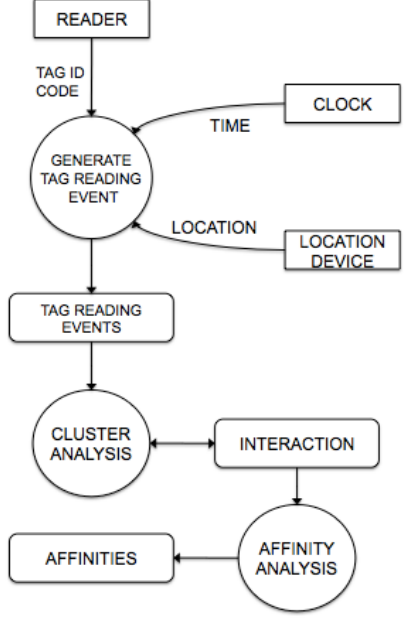
Figure 4. Steps performed by the system to generate interactions and affinities. In the firt step, the RFID-reader reads an electromagnetic tag and sends its DOI to the Generate Tag Reading Event step. The information is packaged as a Interaction Point. Step Cluster Analysis looks for an interaction where the Interaction Point is near to its centroid. Step Affinity Analysis reads new interactions and searches for